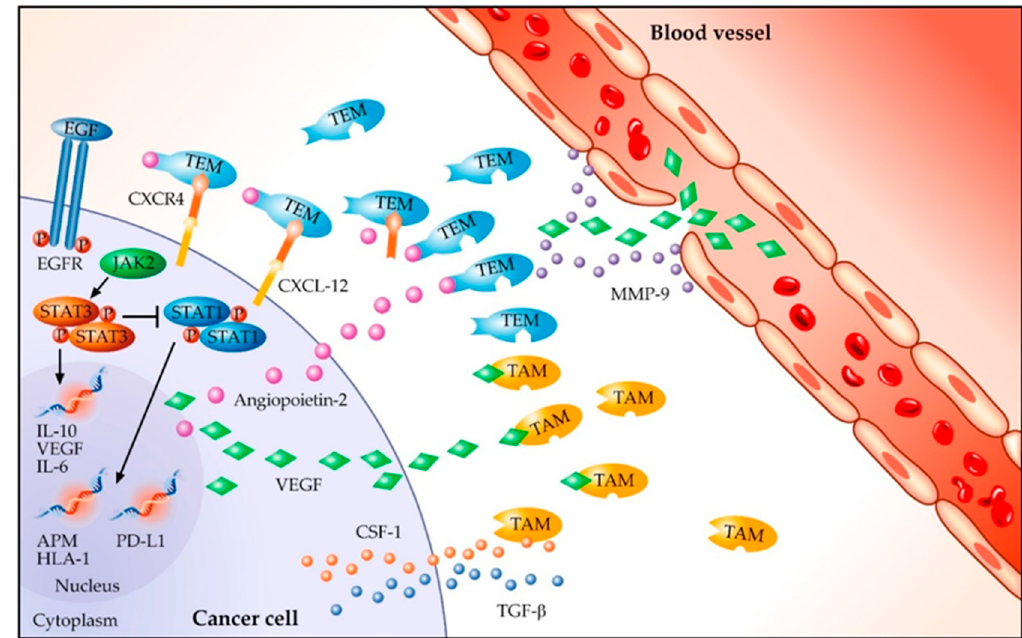
Figure 2. Angiogenetic factors in EGFR mutated NSCLC. EGF, Epidermal Growth Factor; EGFR, Epidermal Growth Factor Receptor; STAT1 / 3, Signal Transducer and Activator of the Transcription1 / 3; Epidermal Growth Factor Receptor; STAT1/3, Signal Transducer and Activator of the JAK2, Janus Activated Kinase 2; IL, Interleukin; VEGF, Vascular Endothelial Growth Factor; APM, Transcription1/3; JAK2, Janus Activated Kinase 2; IL, Interleukin; VEGF, Vascular Endothelial Antigen Presenting Machine; HLA-1, Human Leukocyte Antigen-1; PD-L1, Programmed cell Death Growth Factor; APM, Antigen Presenting Machine; HLA-1, Human Leukocyte Antigen-1; PD-L1, Ligand 1; CSF-1, Colony Stimulating Factor-1; TAM, Tumour Associated Macrophage; TEM, TIE-2 Programmed cell Death Ligand 1; CSF-1, Colony Stimulating Factor-1; TAM, Tumour Associated expressing monocytes; CXCR4, C-X-C chemokine receptor type 4; CXCL12, C-X-C motif chemokine Macrophage; TEM, TIE-2 expressing monocytes; CXCR4, C-X-C chemokine receptor type 4; CXCL12,